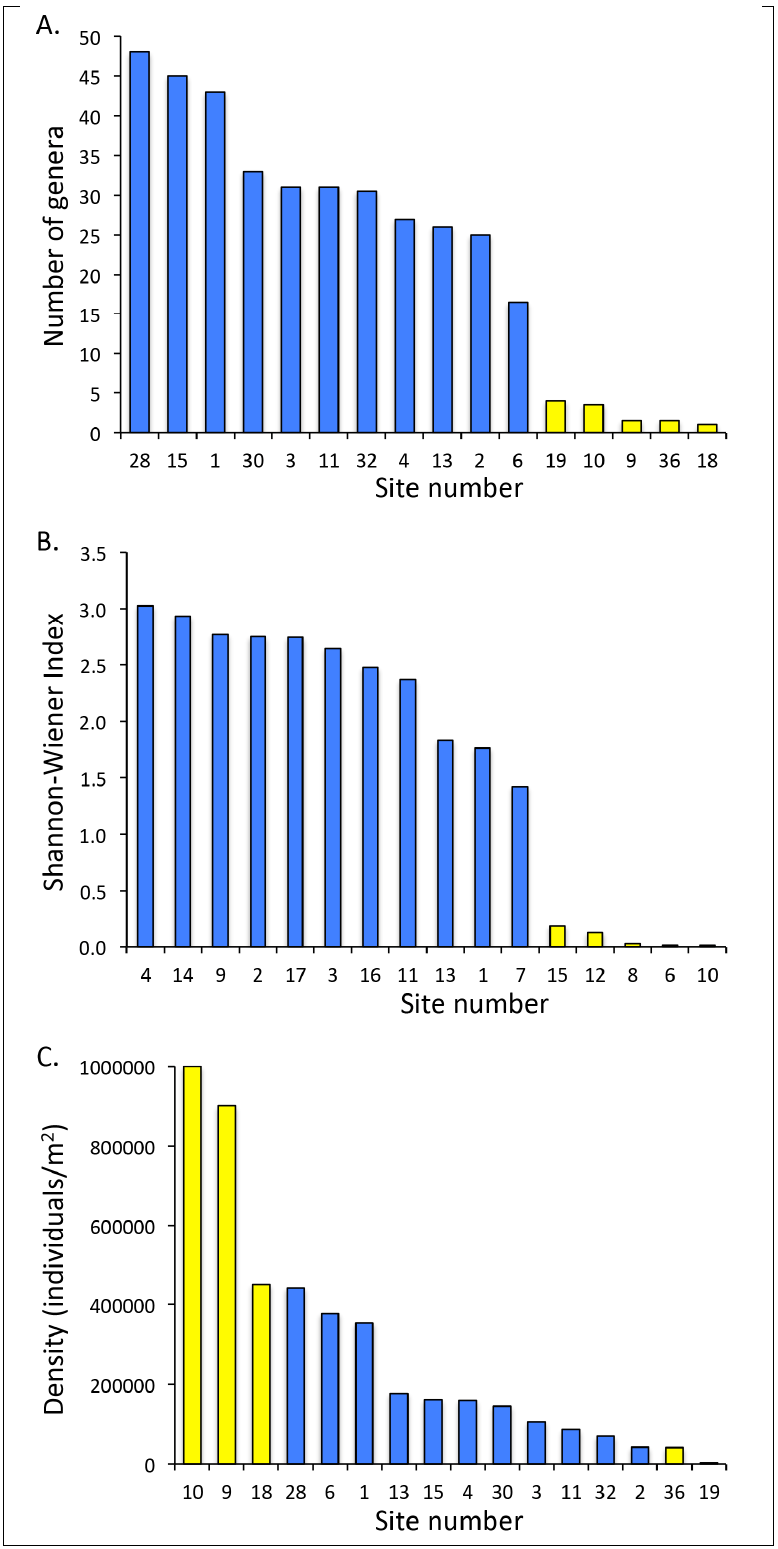
Figure 4. Patterns of macroinvertebrate diversity and density in sulphidic springs and adjacent non-sulphidic reference habitats of Southern Mexico. Bar graphs depict the number of aquatic arthropod genera ( A ); Shannon-Wiener Diversity Index ( B ); and aquatic arthropod densities ( C ) recorded for each site investigated. Non-sulphidic sites are in blue, sulphidic sites are in yellow. Site numbers correspond to IDs in Table